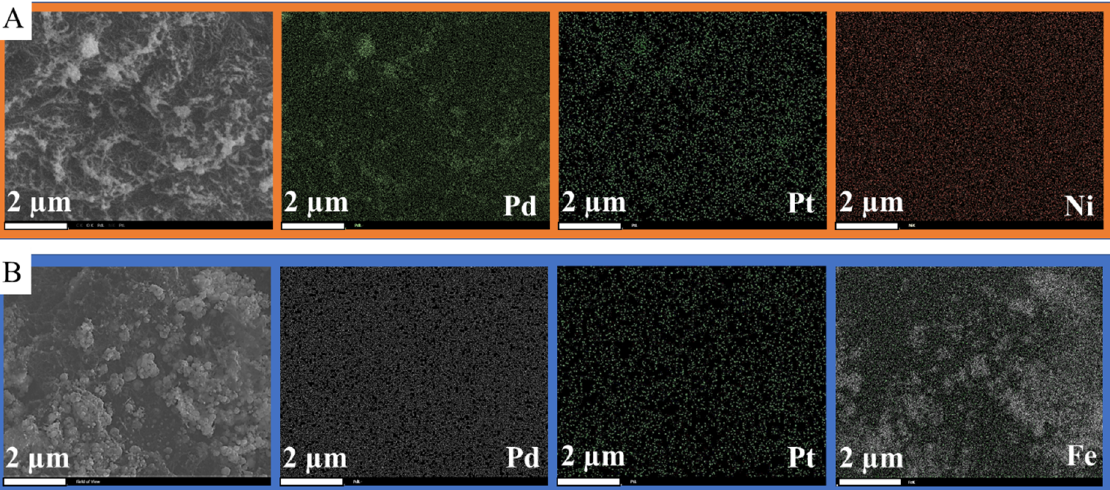
Figure 5. Elemental maps of the nickel ( A ) and magnetite ( B ) containing, palladium and platinum decorated granulated carbon nanocomposites (GCNC).